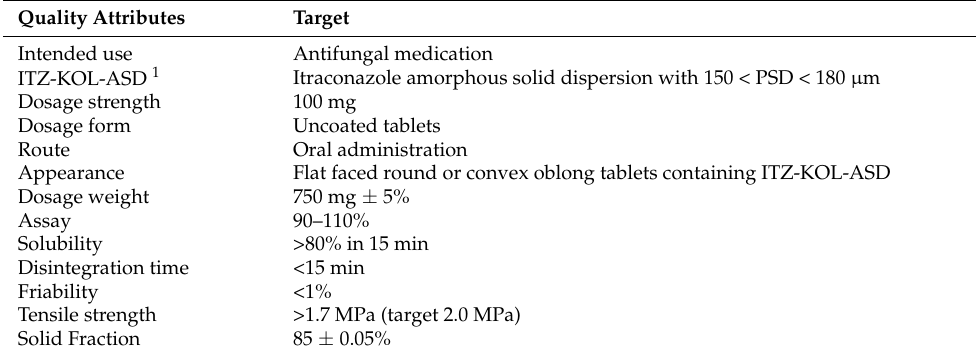
Table 1. Quality Target Product Profile of ITZ-KOL-ASD tablets.